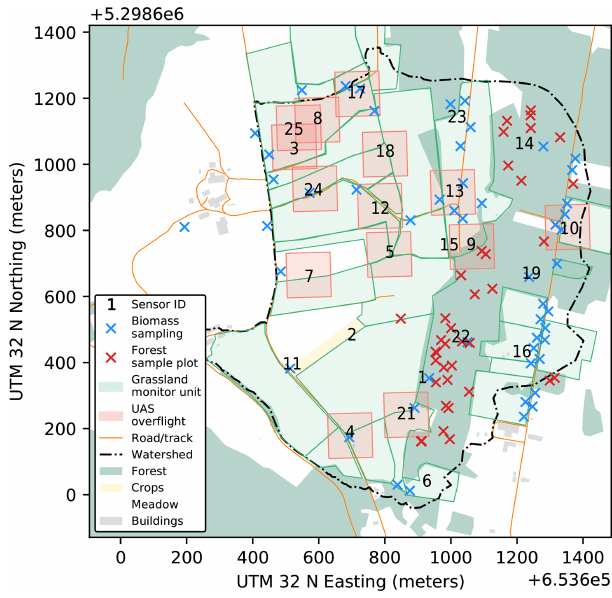
Figure 7. The layout of this figure corresponds to Fig. 1 but shows additional observation campaigns, namely the locations of vegeta- tion biomass sampling (blue crosses, see Sect. 3.9.1), areal units for monitoring the status of meadows (light green), forest/tree surveys (red crosses, see Sect. 3.9.2), and UAS overflight zones (light red, see Sect. 3.10). Basemap data are from OSM (OpenStreetMap con- tributors, 2020); see Sect. 4.4.